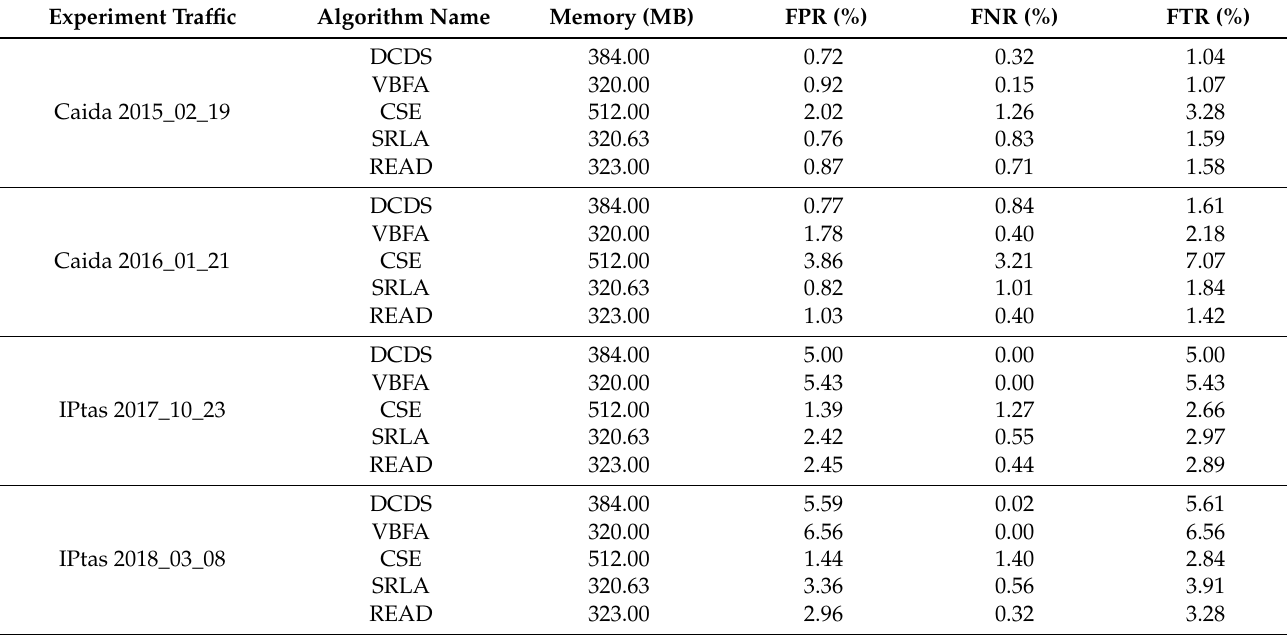
Table 3. Memory and false rate.